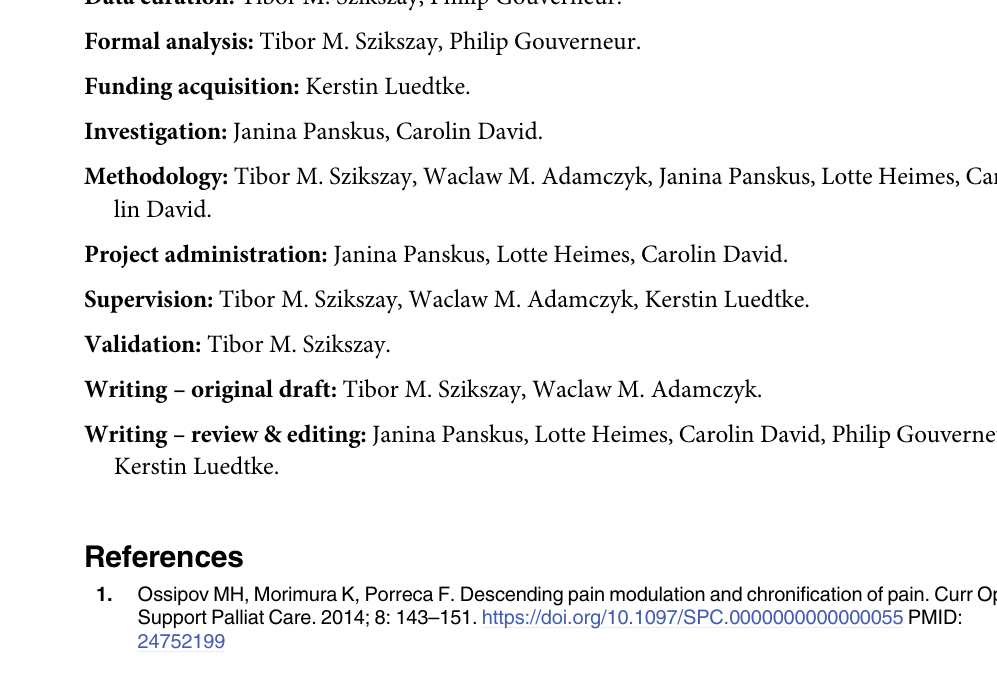
S1 Table. Correlation analysis of pain scores within the third time interval (T3) and included questionnaires. PHQ9: Patient Health Questionnaire; PVAQ: Pain Vigilance and Awareness Questionnaire; PSQ: Pain Sensitivity Questionnaire; STAIT-SKD: State-Trait-Anx- iety-Inventory-SKD; SDS-17: Social Desirability Scale-17; MAAS: Mindful Attention